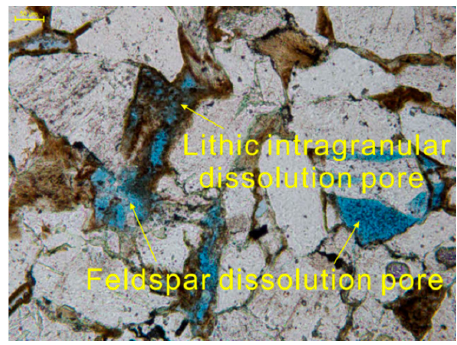
Figure 11. Feldspar dissolution pore and lithic intragranular dissolution pore of the BSMT type of pore-throat structure (Sample #42).